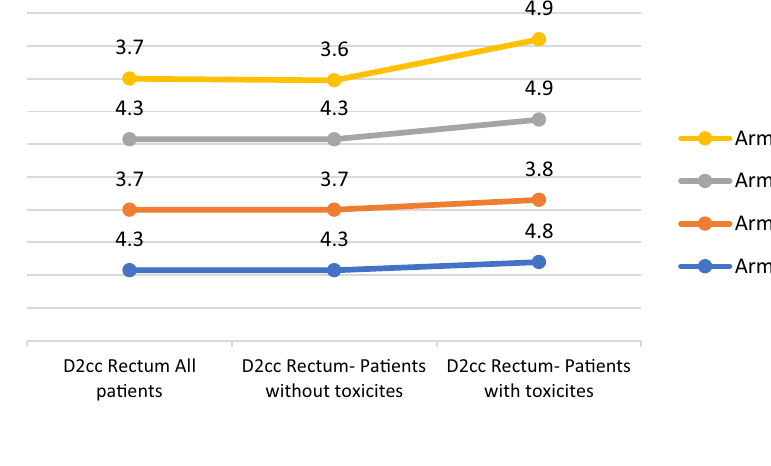
Fig. 6 Comparison of tox- icities and dose received to rectum per session of brachy-